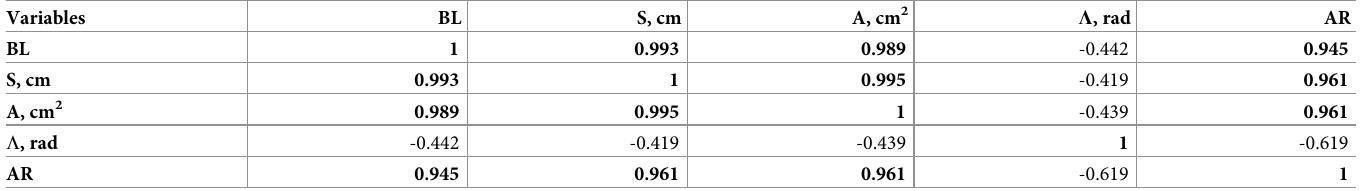
AR 0.945 1 Values in bold are different from 0 with a significance level alpha =